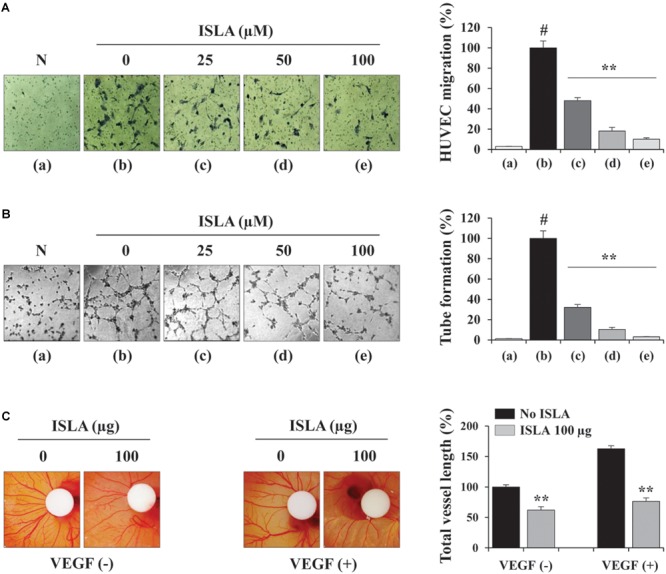
Isoliquiritin apioside decreased the angiogenic abilities of HUVECs. (A) HUVECs were treated with or without ISLA for 12 h and suspended in EBM-2. The migration of HUVECs induced by EGM-2 across the Transwell® membrane was evaluated after 15 h. Migration induced by EBM-2 was used as a negative control (N). Relative migration compared with untreated control cells was calculated and expressed as the mean ± SD (n = 5). (B) HUVECs treated with or without ISLA for 12 h were suspended in EGM-2 and then loaded onto BME-coated wells. After incubating for 4 h, capillary-like tube formation was visualized by phase contrast inverted microscopy. Untreated HUVECs suspended in EBM-2 were used as a negative control (N). The number of tubes was counted in triplicate samples, and relative tube formation compared with untreated HUVECs was calculated. Data are expressed as means ± SD (n = 3). (C) On ED day 6, filter disks containing ISLA (100 μg) and/or VEGF (200 ng) in PBS (20 μL) were carefully loaded onto the CAM. After sealing the window with adhesive tape, the eggs were incubated for 3 days in an egg incubator. On ED day 9, the vessels in the eggs were photographed, and the total vessel length was measured by ImageJ software in three samples per group. Relative vessel length compared with HUVECs without ISLA and VEGF treatments was calculated and expressed as the mean ± SD (n = 3). #p < 0.01 vs. untreated control, ∗∗p < 0.01 vs. ISLA-untreated control.